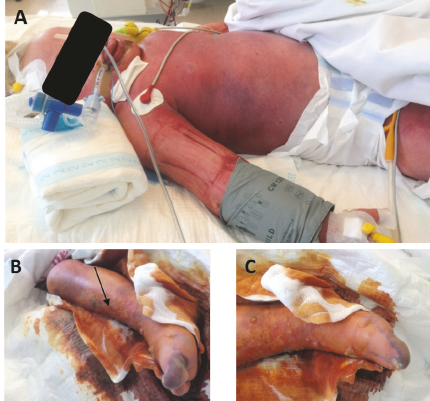
Figure 1: Diffuse erythroderma, purpura, and petechiae with severe generalized edema (A). Erythroderma, livid swelling, confluent bullae, and diffuse desquamation of the right leg (B, C). Arrow indicates site of the initial insect